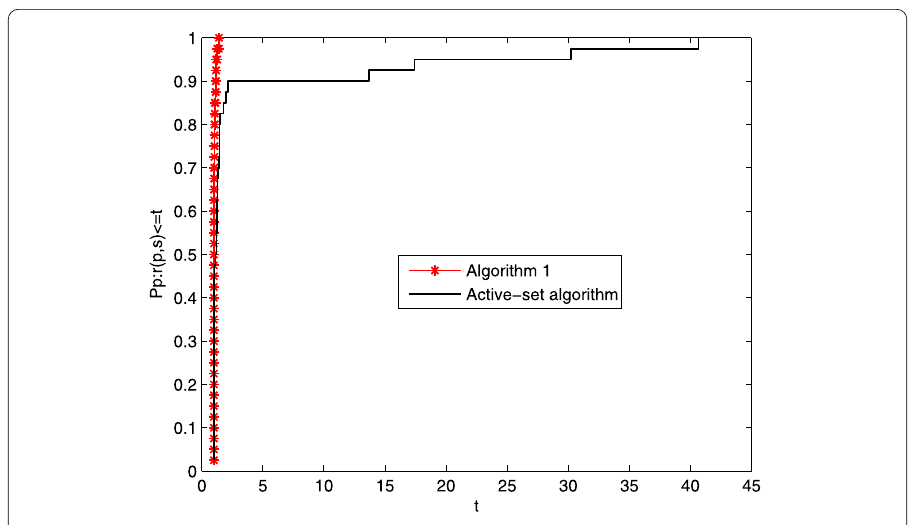
Figure 1 Performance of cpu-Time of these two